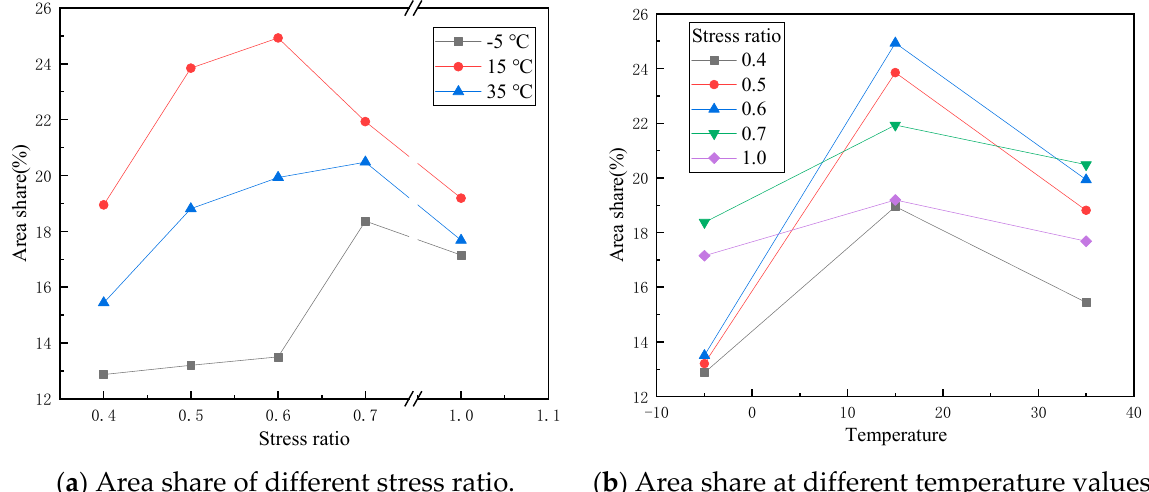
Figure 7. Area share of grouting material in the fracture surface.